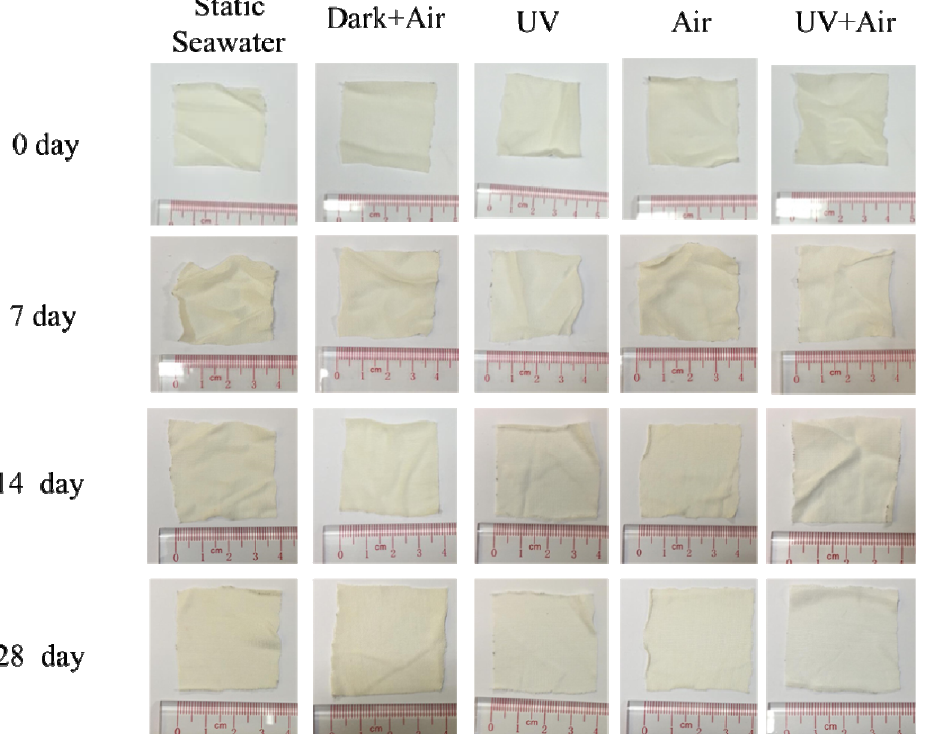
Figure 4. Visual images of multi-filament PLA/PHB fabrics before (0 days) and after 7 days, 14 days and 28 days degradation and immersion time under different conditions. Each sample was dried at 60 °C in vacuum for 48 h.